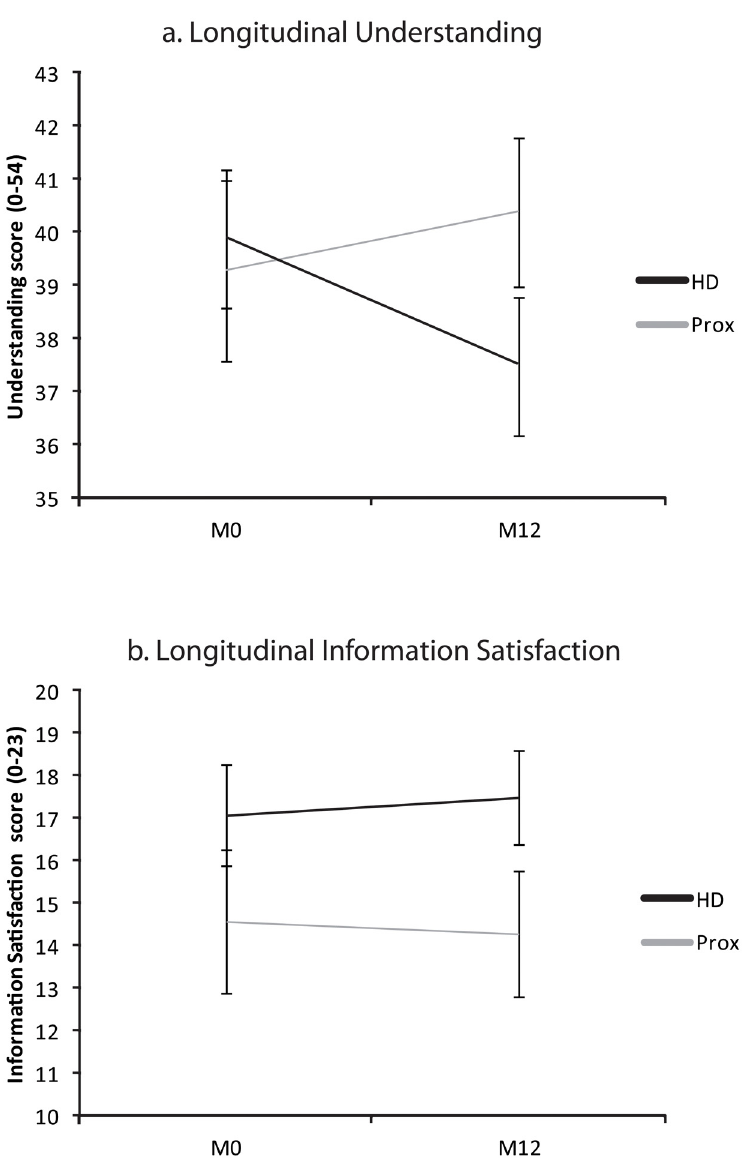
Fig 1. Longitudinal analysis of information processing. Huntington ’ s disease patients (HD) and proxies had a similar understanding of the protocol at M0. Comprehension score decreased over time in the HD patients, whereas it remained stable in their proxies (Prox). Satisfaction with the information provided remained stable in both patients and proxies. Error bars represent standard